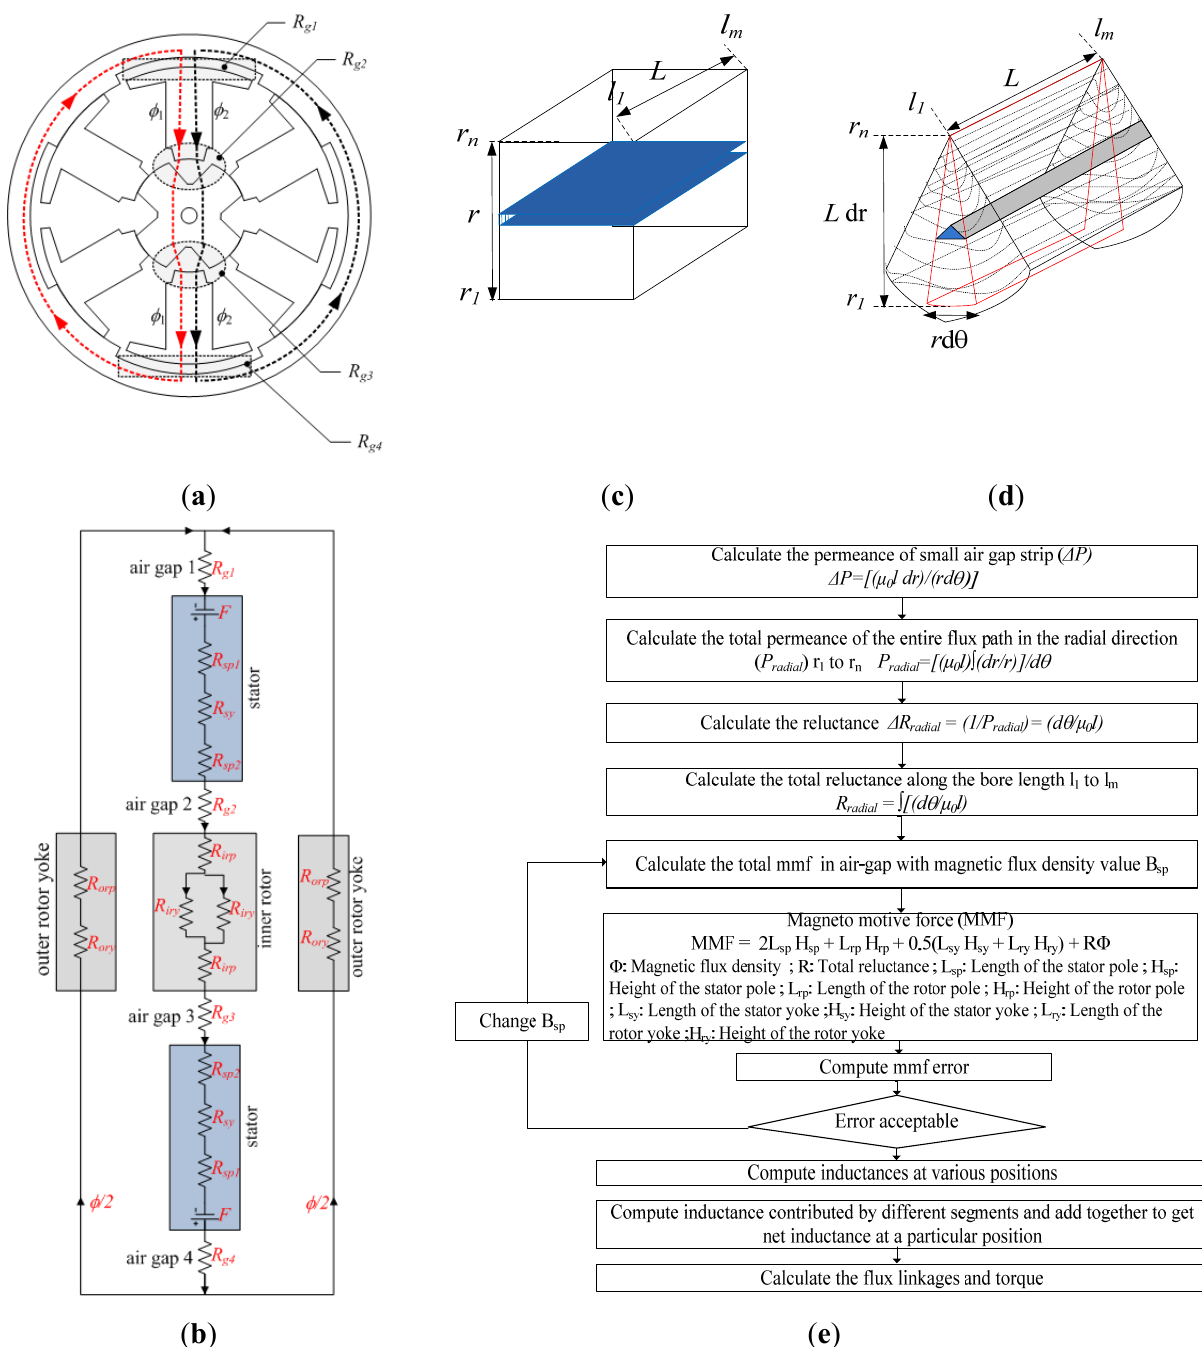
Figure 4. Magnetic circuit network: ( a ) Flux flow; ( b ) Reluctance network; ( c ) Iron core calculations; ( d ) Airgap calculations; ( e ) Algorithm used for